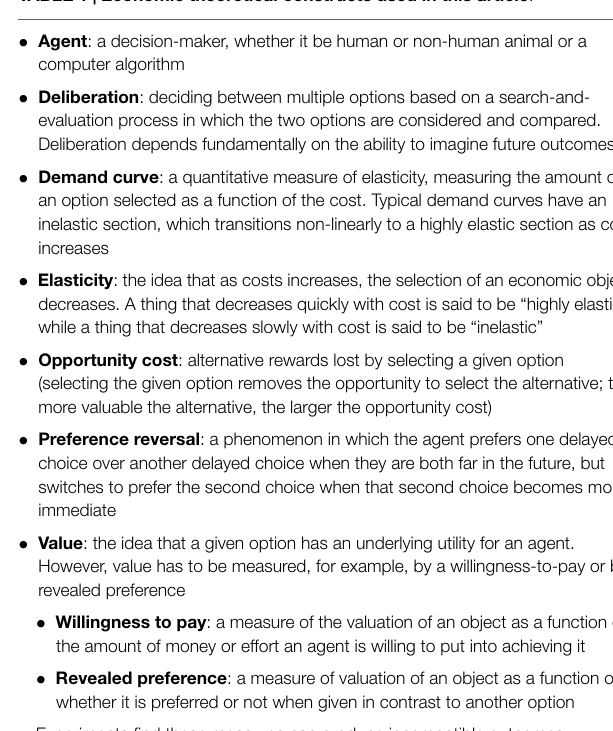
TABLE 1 | Economic theoretical constructs used in this article